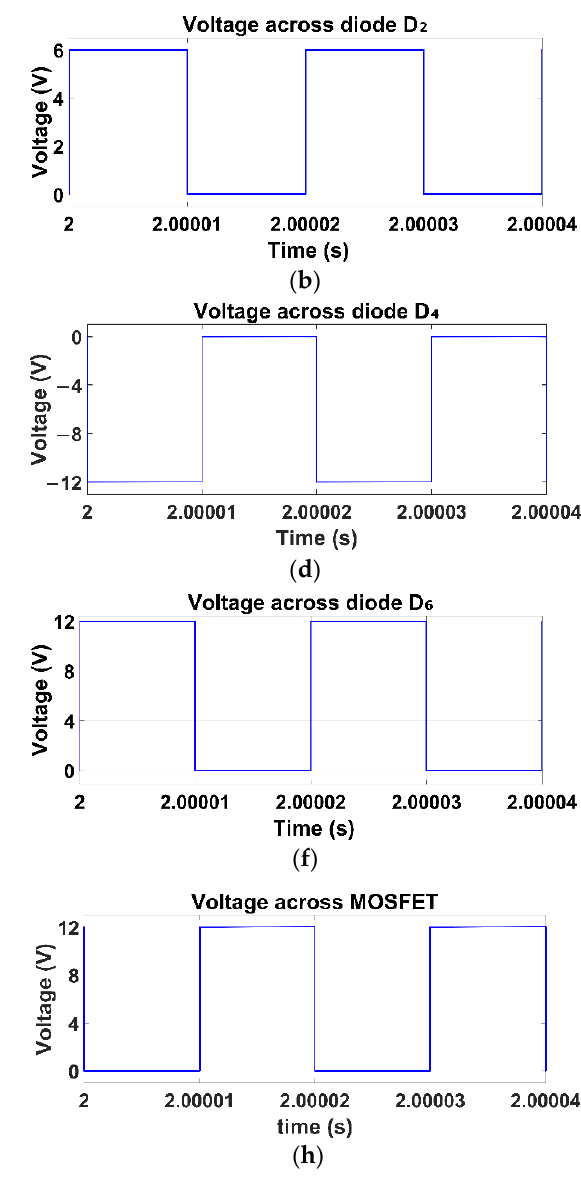
Figure 8. Output voltages at duty cycles D = 0.3, D = 0.5 and D = 0.7 and V in = 3V. Figure 9. Voltage gains of different topologies at different duty cycles.